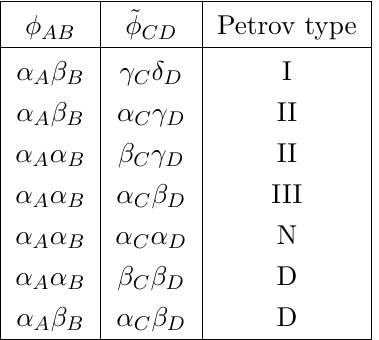
Table 2 . Various combinations of principal null directions for two electromagnetic spinors lead to Weyl tensors of different Petrov types under the mixed Weyl double copy of eq. (2.25).